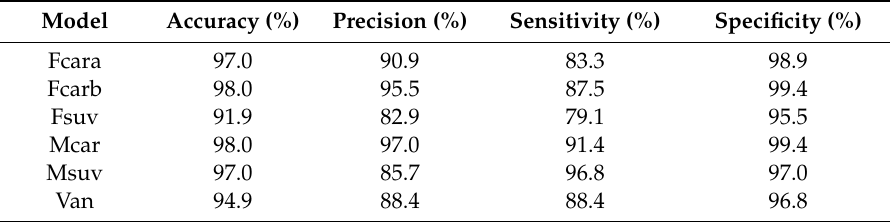
Table 10. The recognition indicators of each model were calculated based on the data in Tables